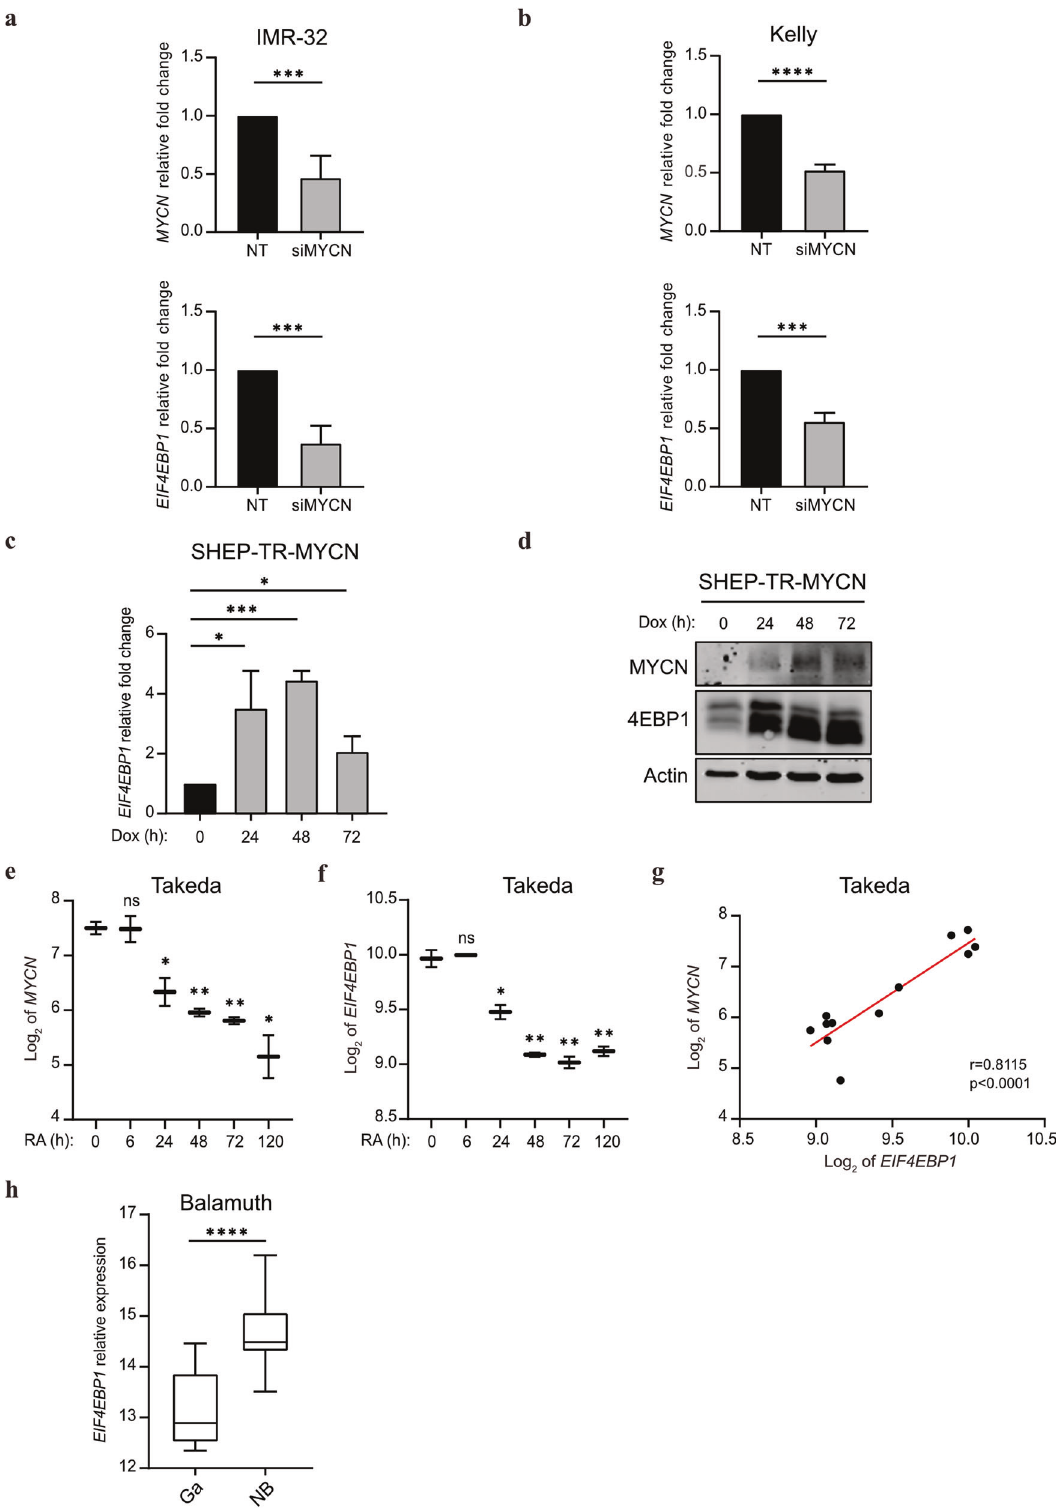
hypoxia by stimulating the synthesis of pro-angiogenic factors, like HIF-1 α and VEGF, to facilitate tumor angiogenesis in vivo [28]. In addition, the control of mRNA translation was shown to be critical to prevent the deleterious effects of MYCN and MYC overexpression, as we and others previously reported [37]. In